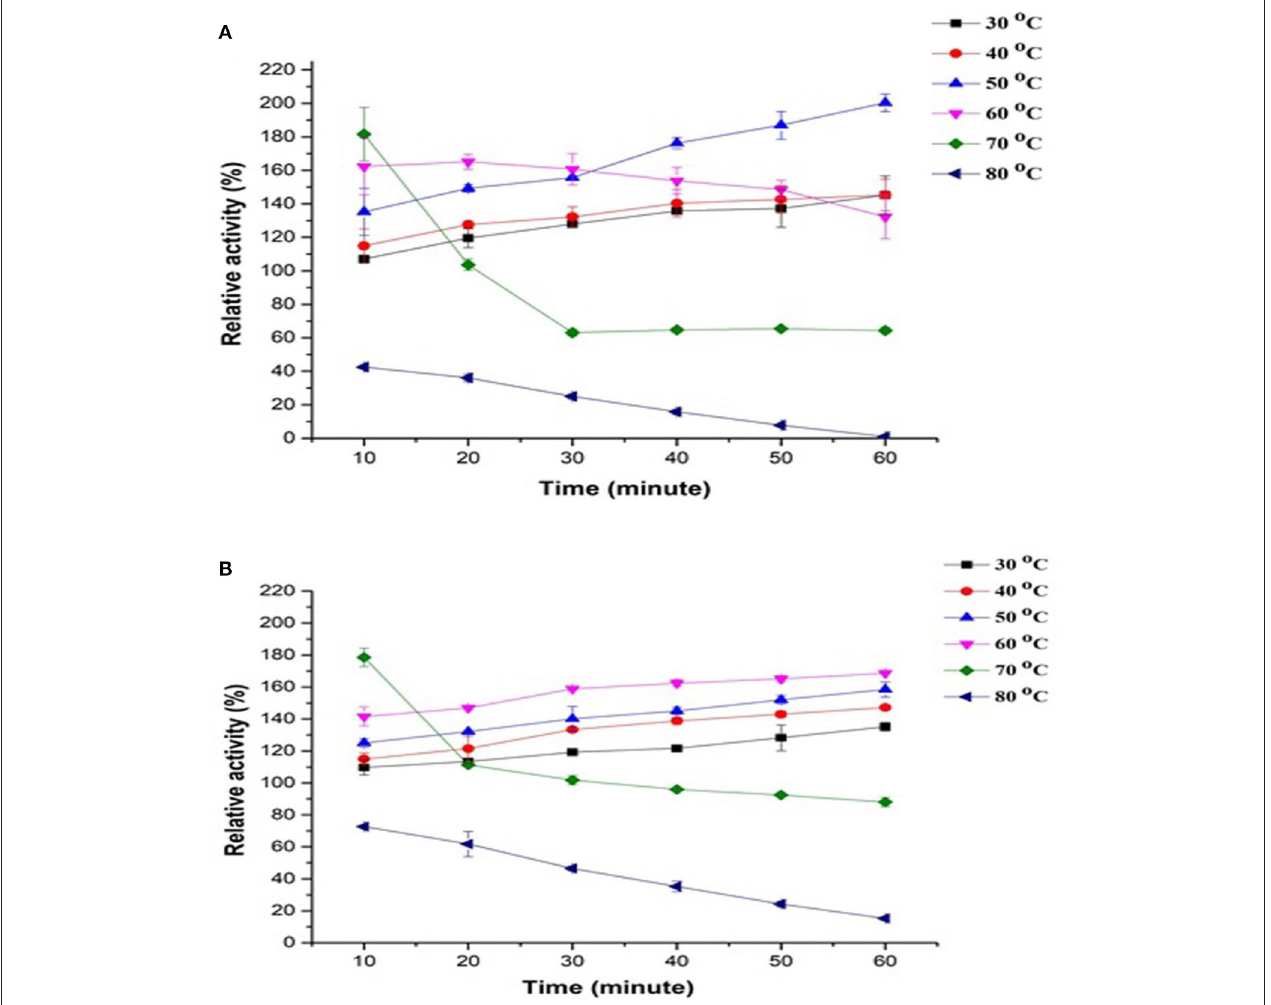
FIGURE 1 | Effect of temperature stability on relative activity of crude apple juice polyphenol oxidase (PPO) by incubating at 30–80 ◦ C for 10–60min and by using different substrates, namely, (A) catechol and (B) pyrogallol. All data were the means ± SD